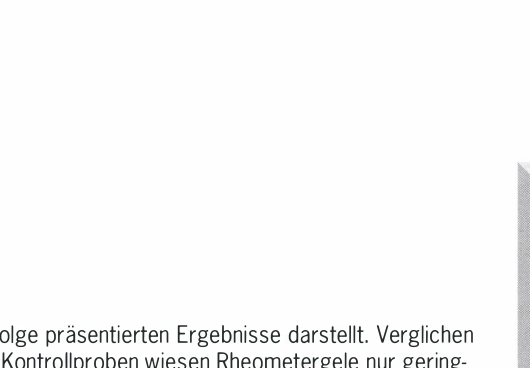
Fig. 2: Strain-dependency of